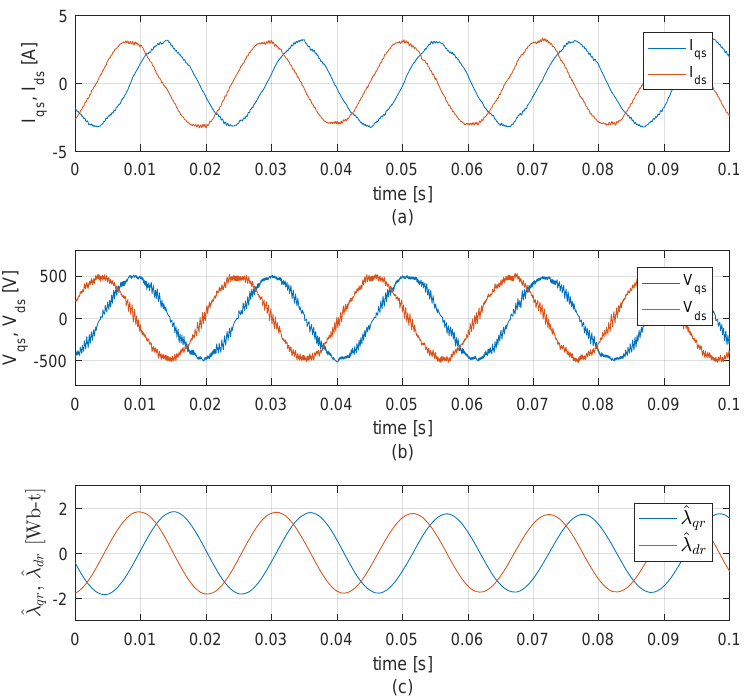
Figure 7. Evaluation of RFLO under no load conditionL ( a ) qd current components; ( b ) qd voltage components; ( c ) qd estimated rotor flux linkage